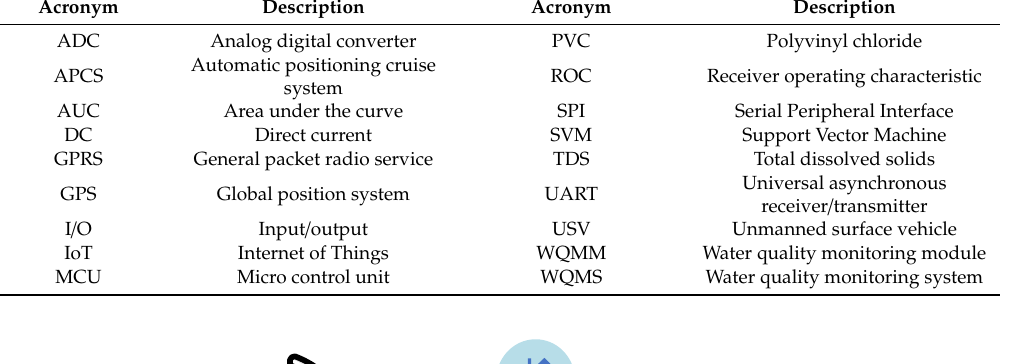
Table 1. Acronyms used in this paper.